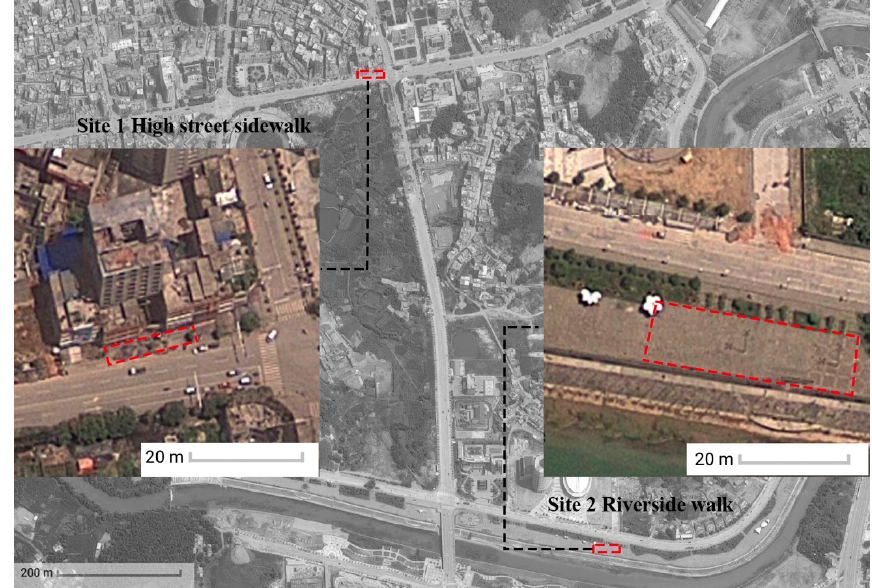
Figure 1. Map showing the two sites in the case study city and the urban morphology of the city.